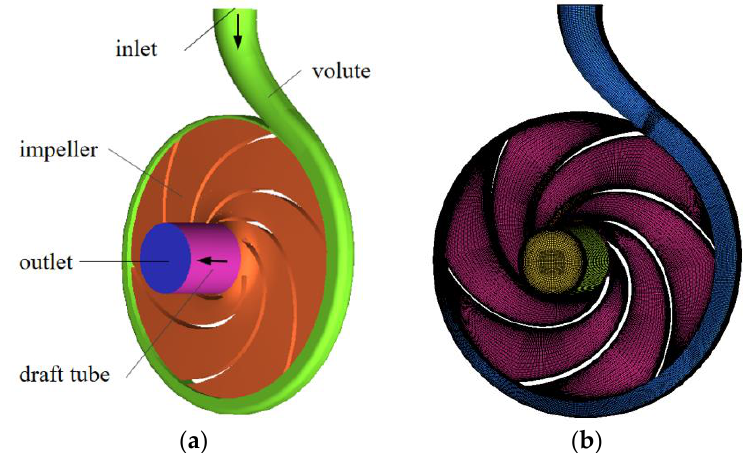
Figure 3. Computational domain and meshing of PAT flow field: ( a ) PAT computational domain of flow field; ( b ) Computational domain meshing of PAT.